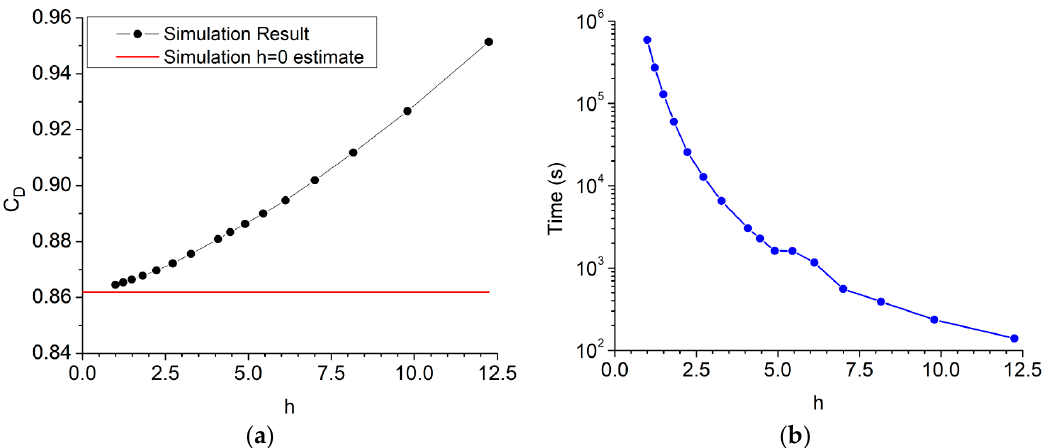
Figure 9. The simulation result of a flow passes through a cylinder: ( a ) C D ; ( b ) time. Table 6. The precision test result of the simulation of a flow passes through a cylinder.